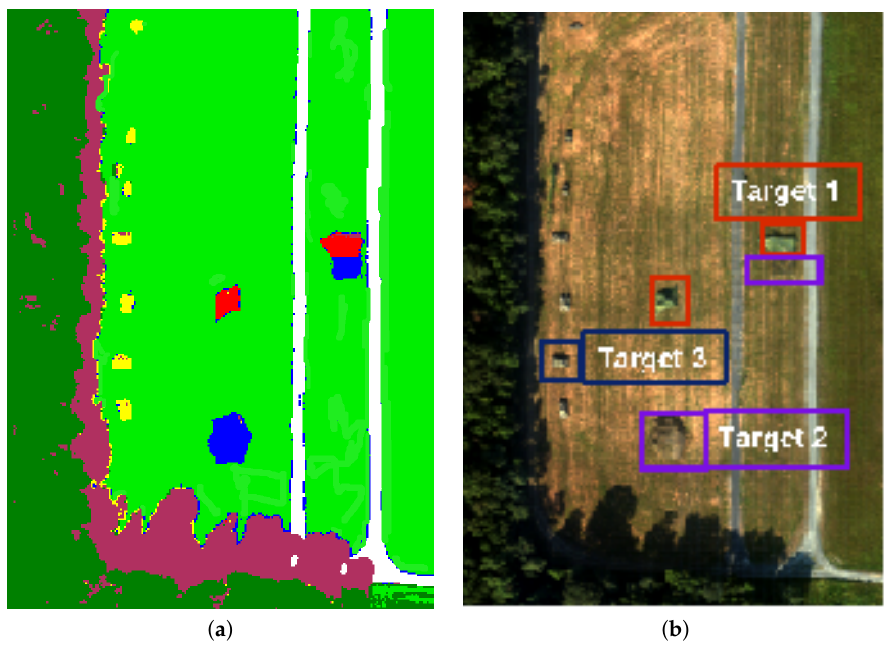
Figure 13. HSI images: ( a ) ground truth; ( b ) classes in HYDICE HSI.